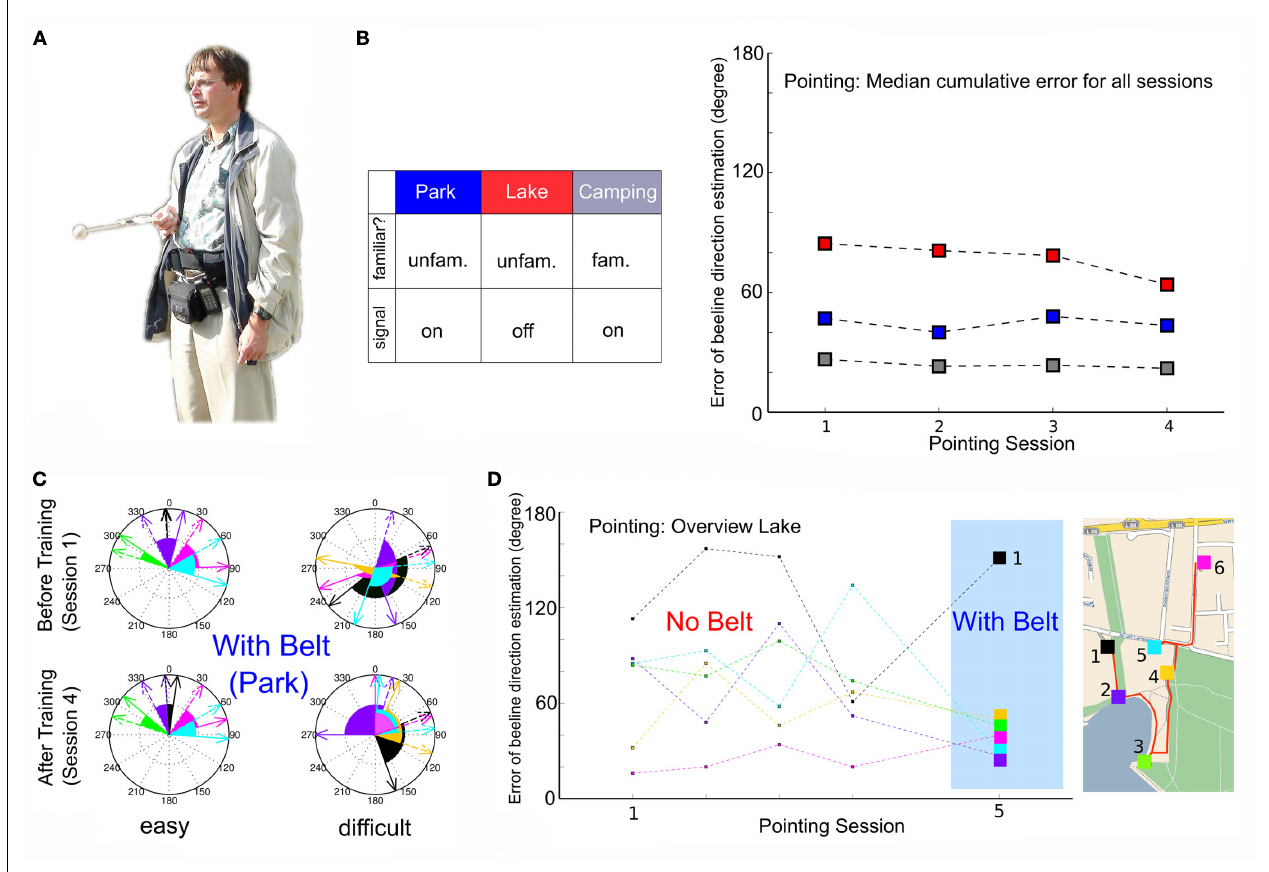
estimated angular direction is the angular pointing error.The subject perceived the location on the right as “difficult” and the location on the left as “easy.” Green arrows mark the subject’s pointing estimation from the “easy” location to the “difficult” location; orange arrows mark the subject’s pointing estimation from “difficult” to “easy.” (D) At the lake (no belt): median pointing error for the six different locations. In session 1–4, the belt was not worn, and the subject pointed based on his internal estimate of the environment. In the fifth session, the subject’s belt was switched on. In the first location (in black) the belt’s information was of no use for the subject. In the subsequent locations, the subject’s median pointing error decreased. On the right is a map of the environment, including the object’s locations and the track chosen in the fifth